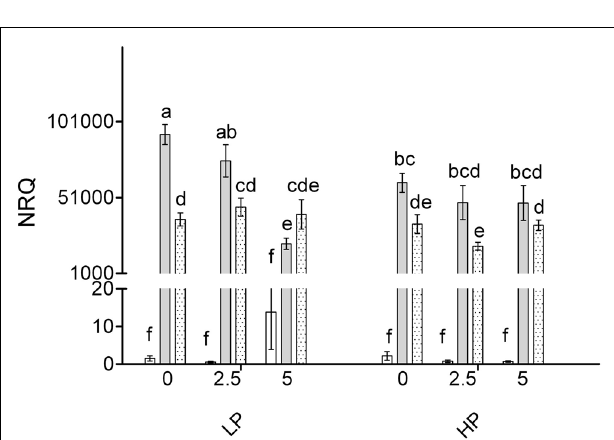
FIGURE 6 | Normalized relative quantity (NRQ) of MtPht1;1 in roots of non-mycorrhizal (open bars) and mycorrhizal ( G. intraradices , gray bars and G. mosseae , dotted bars) medic ( Medicago truncatula ) grown in pots with different phosphorus (P) levels, 10 and 20mgPkg − 1 soil (LP and HP, respectively) and with no arsenic (As) added to the soil (0As) or